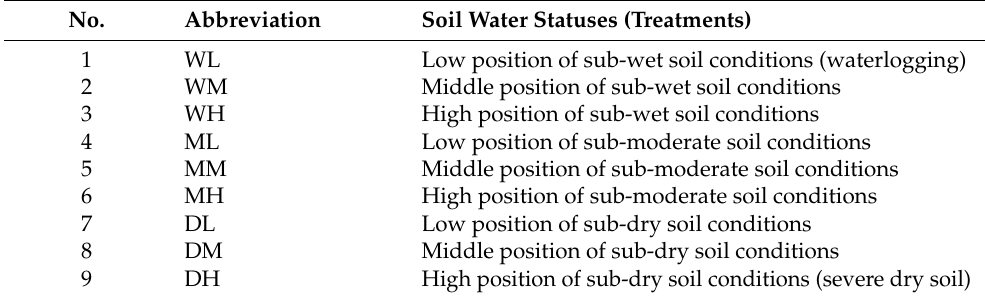
Table 3. Explanation of soil moisture statuses (treatments) in experiment